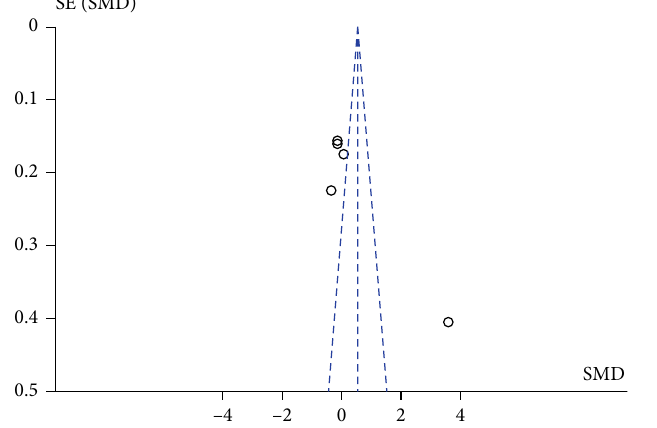
Figure 5: Funnel plot of fi ve studies that performed an intervention with more than 35 training sessions with muscular strength